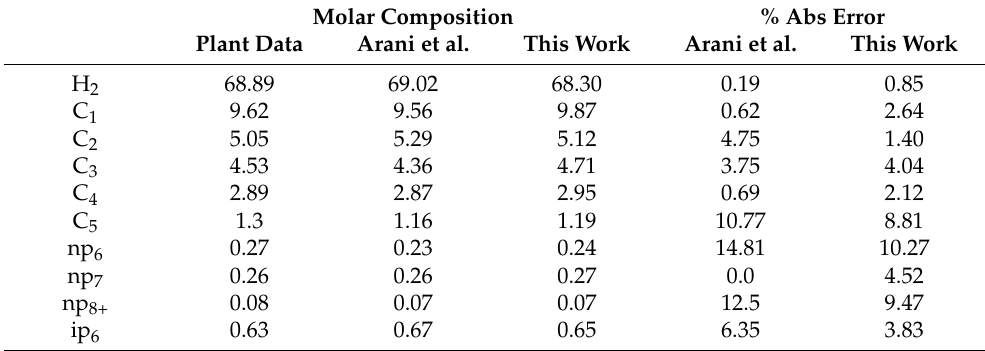
Table 9. Model prediction of the industrial plant